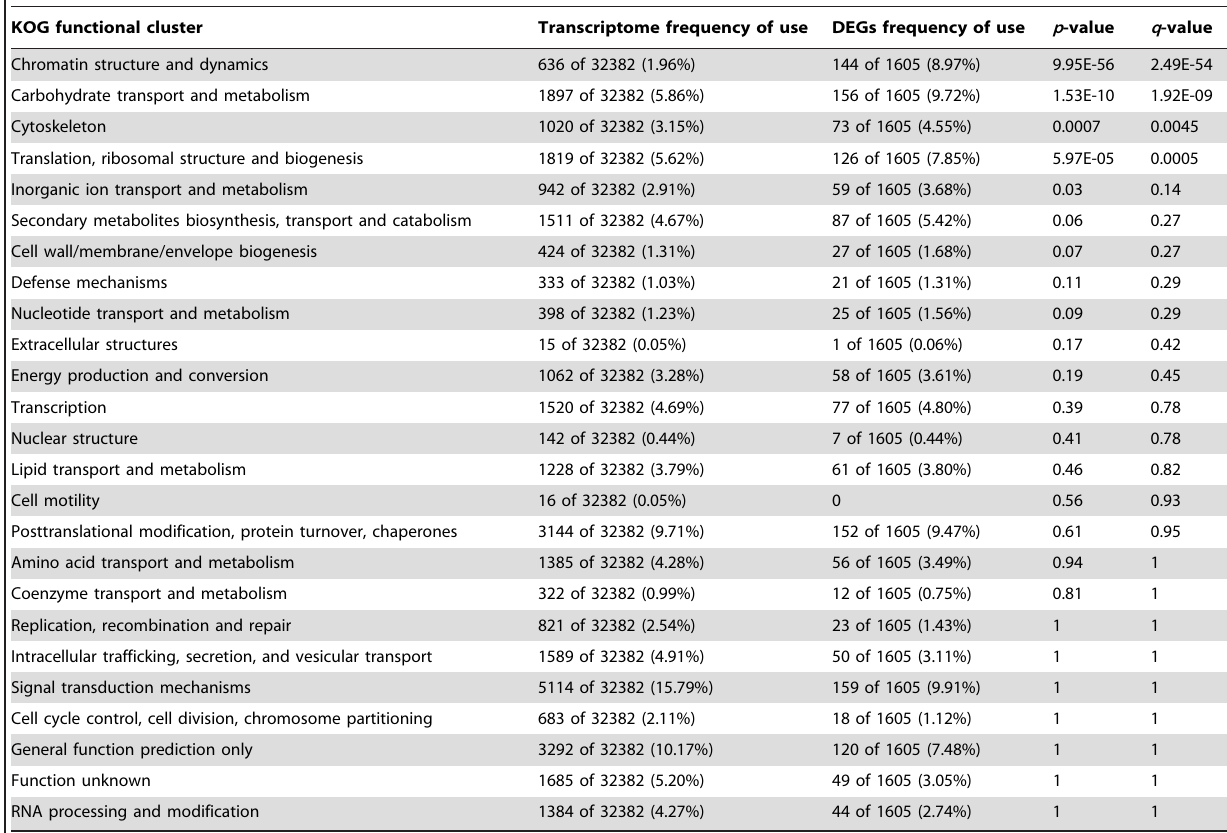
KOG functional cluster Transcriptome frequency of use DEGs frequency of use